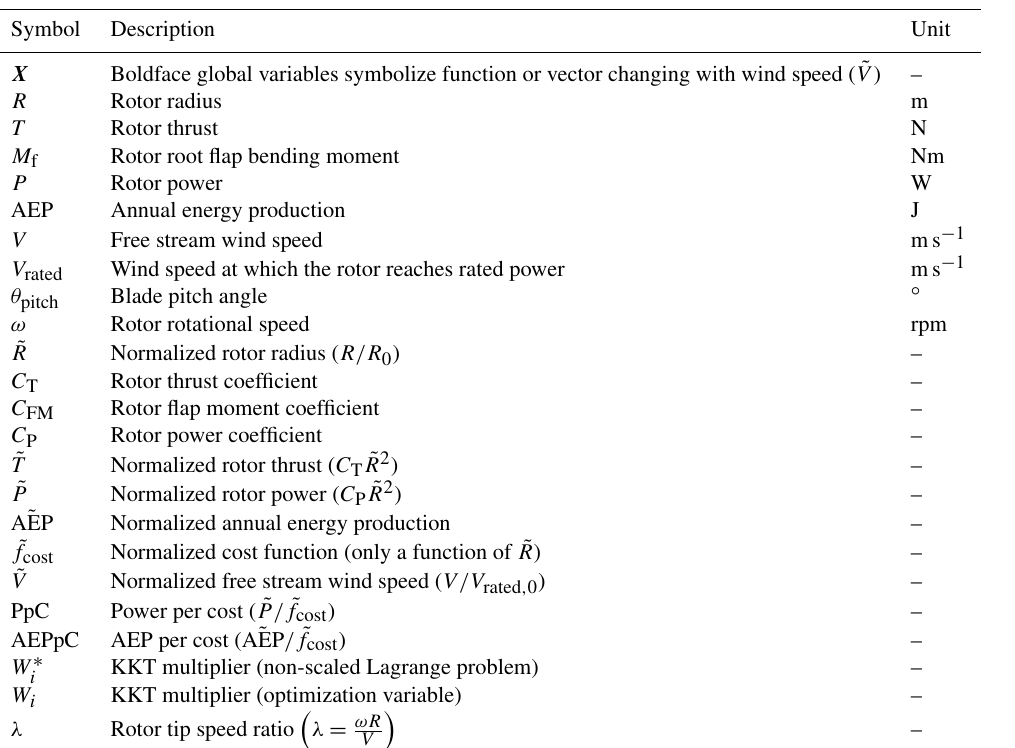
Table A1. Variables that are scalars for the whole rotor. Boldface variables indicate the variable is a function or vector that changes with wind speed.